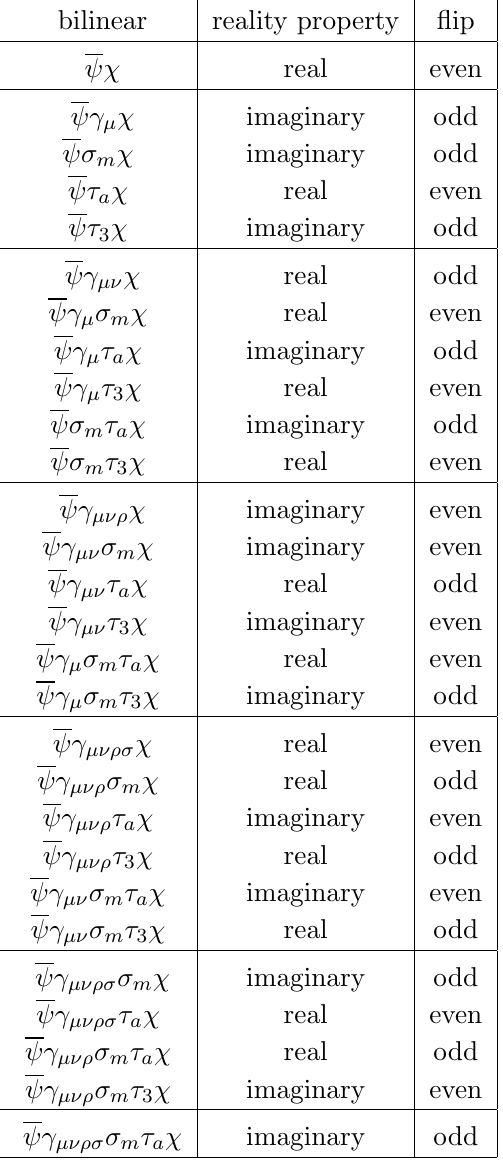
Table 12 . The reality properties and the properties under Majorana (cid:13)ip of various fermionic bilinears. The analogous properties for all the other bilinears can be derived from those in this table using the duality relations in eq.